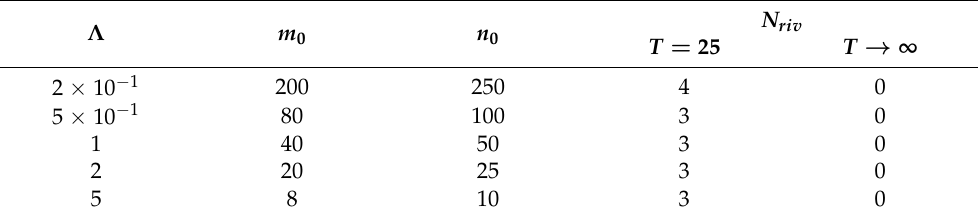
Figure 12. Film thickness solution at T = 25: Λ = 2 × 10 − 1 ( a ); Λ = 2 ( b ). Bo = 10 − 1 , θ s ∈ [ 45 ◦ , 60 ◦ ] , α = 60 ◦ . Table 1. Number of rivulets observed after T = 25 and at steady state solution ( T → ∞ ) as a function of the characteristic length Λ of the heterogeneous surface. Bo = 0.1, θ s ∈ [ 45 ◦ , 60 ◦ ] , α = 60 ◦ , L X = 40, L Y =